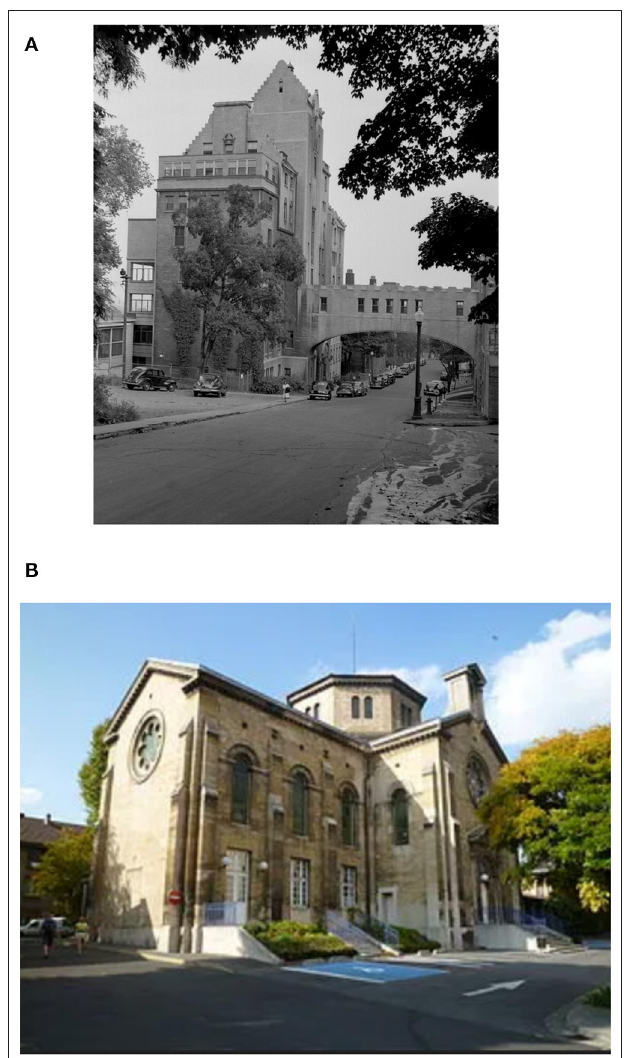
FIGURE 1 | Historical sites central to the development of cognitive mapping: (A) the Montreal Neurological Institute, Montreal, Canada and (B) St. Anne Hospital, Paris,